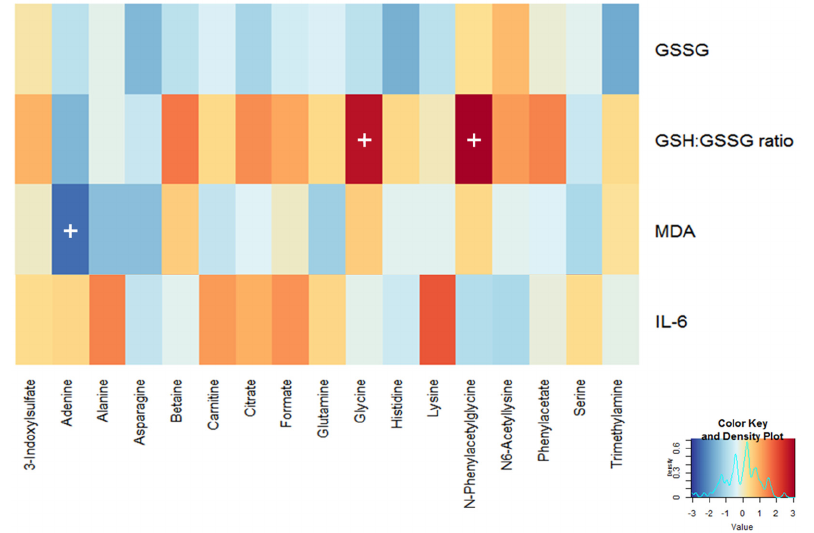
Figure 2. Correlation heat map generated by a generalized linear mixed model analysis of four traditional biomarkers with seventeen urinary metabolomic signatures. Red and blue colors indicate negative and positive t ‐ values, respectively. A cross indicates a p ‐ value < 0.05.